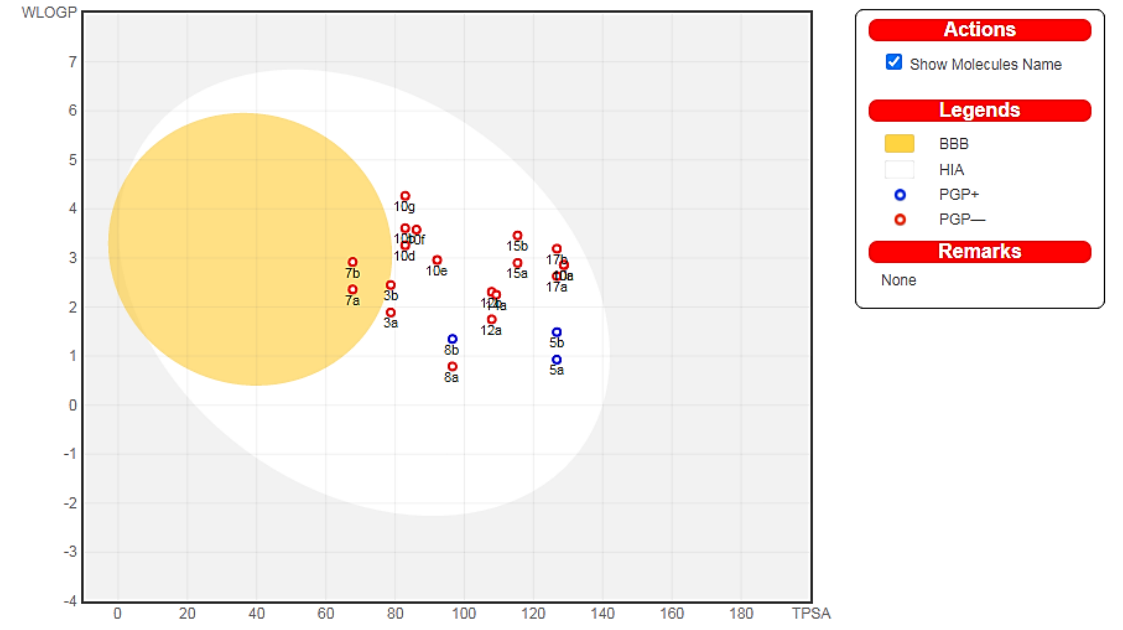
Figure 11. BOILED-Egg depiction of the designed molecules.